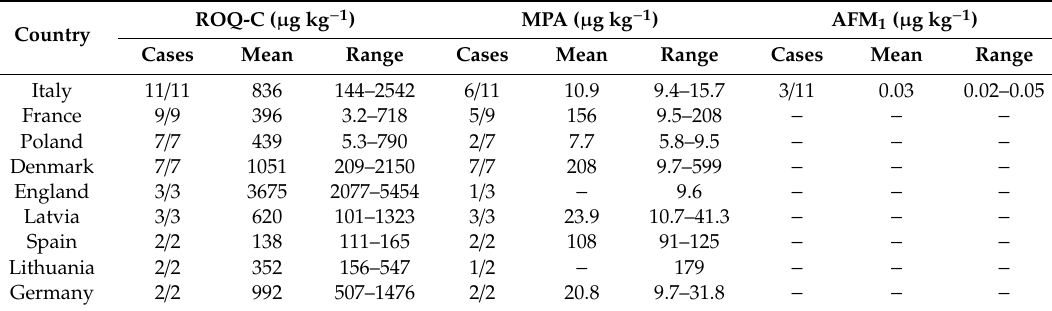
Table 3. The concentrations of mycotoxins found in blue cheese